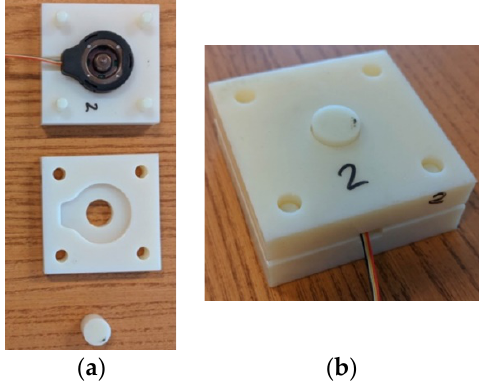
( c ) Figure 2. Custom frame realized to house the load cells: ( a ) first part of the new frame fixed on the chair structure; ( b ) second part of the new frame fixed under the seat; ( c ) load cells housing. To place the load cells under the LP, a specific adaptor was designed and realized by means of